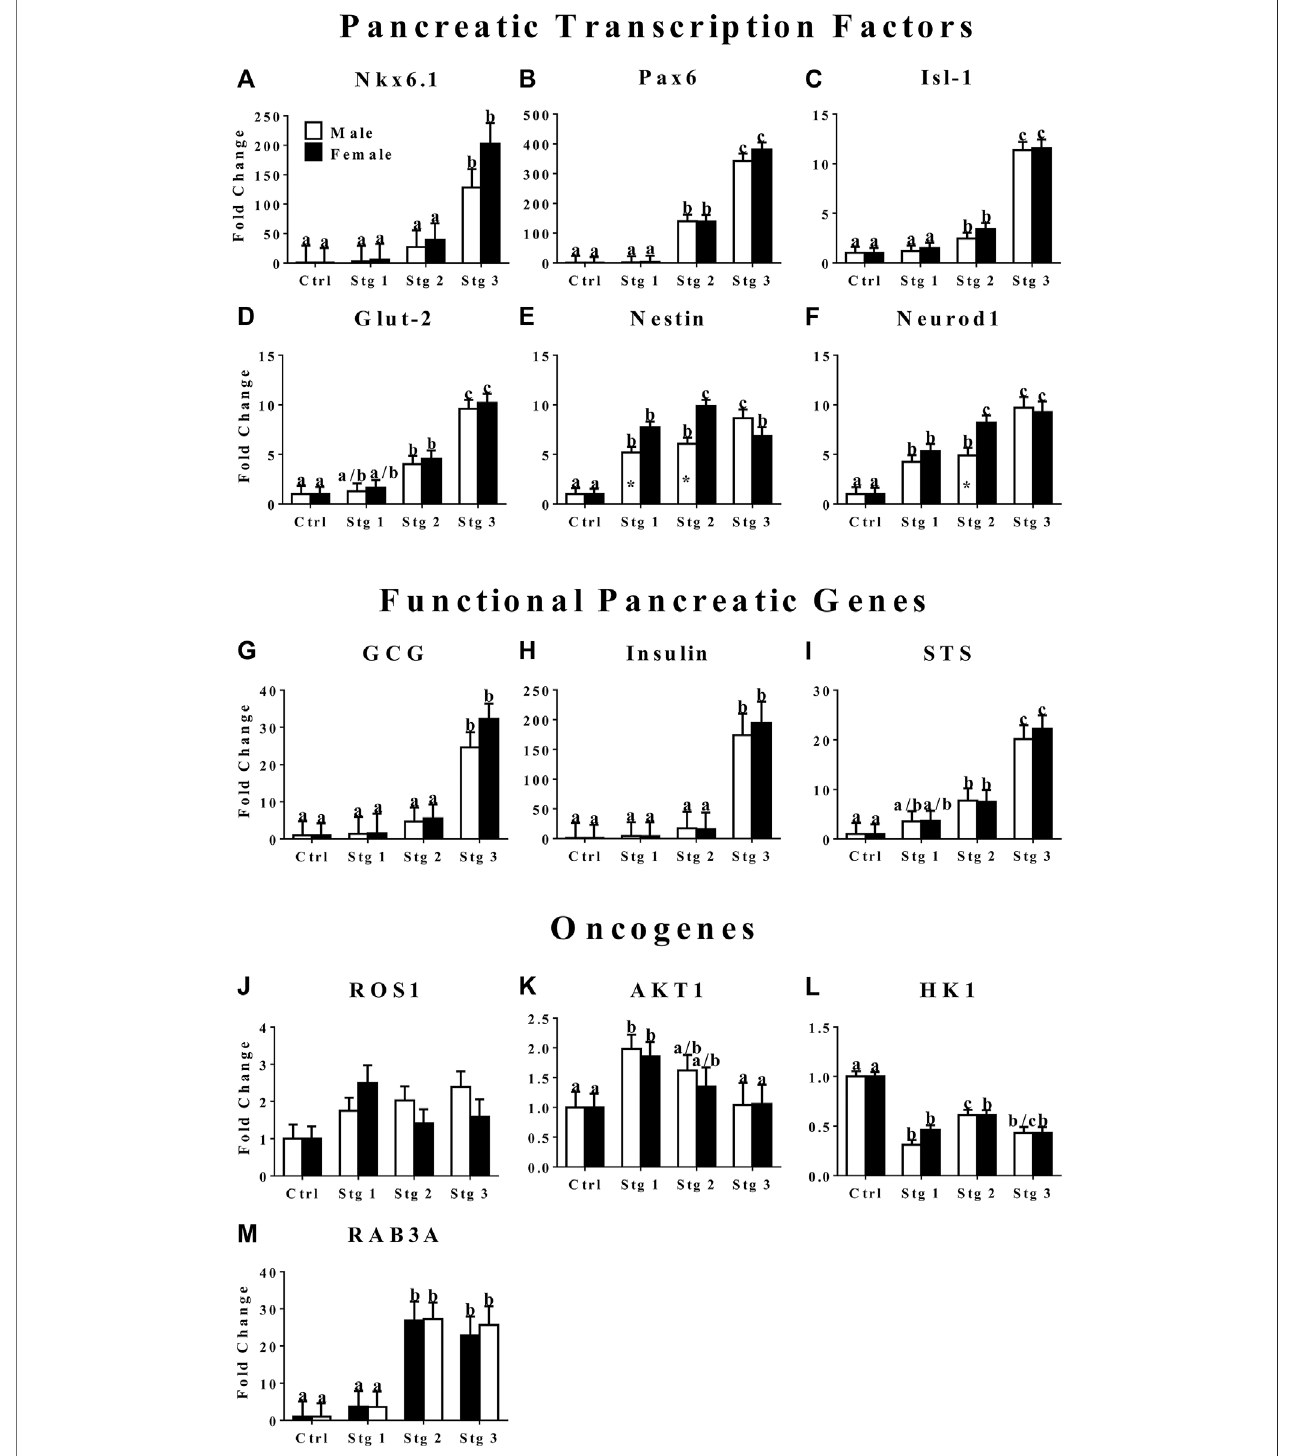
FIGURE3| Foldchange(2 − ΔΔ Ct ,LSmean±SEM)offelinetranscriptionfactor,NK6homeobox1[Nkx6.1, (A) ],pairedbox6[Pax6, (B) ],ISLLIMhomeobox1[Isl-1, (C) ],glucosetransporter2[Glut-2, (D) ],nestin (E) ,neurogenicdifferentiationfactor1[Neurod1, (F) ];functionalpancreatic,glucagon[GCG: (G) ],insulin (H) ,somatostatin [STS: (I) ];andoncogene,tyrosine-proteinkinaseROS1[ROS1: (J) ],AKTserine/threoninekinase1[AKT1: (K) ],hexokinase1[HK1: (L) ],andRas-relatedproteinRab-3A [RAB3A: (M) ] expression levels by feline ASCs after culture in three stages (stg 1,2,3) of pancreatic differentiation media or stromal medium (Ctrl). Columns with distinct superscripts are signi fi cantly different among induction stages within sexes and those with asterisks are different between sexes within induction stages ( p <